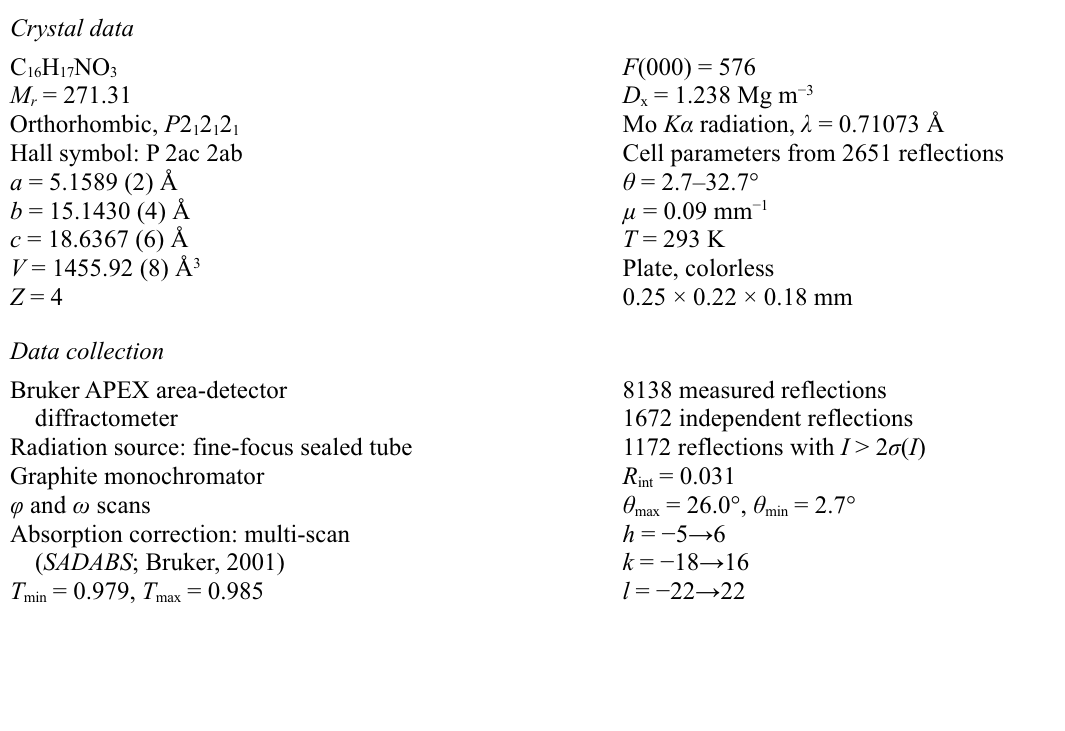
The molecular structure of (I), showing 50% probability displacement ellipsoids (arbitrary spheres for H atoms). ( S )-Benzyl